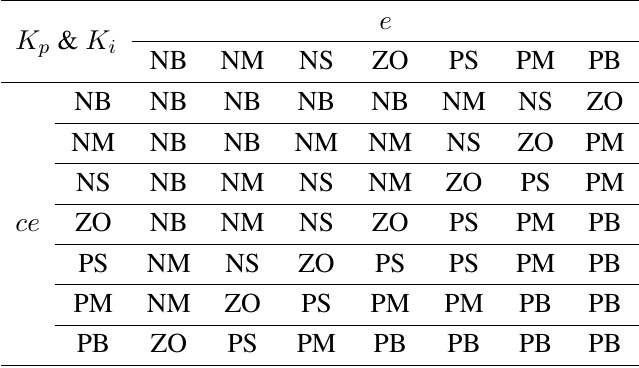
Table 1. Fuzzy membership